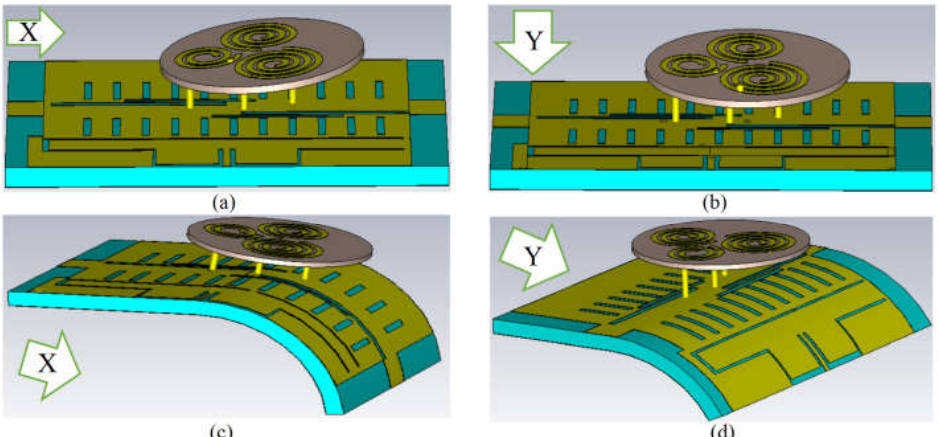
Figure 19. The crumpled antenna for both parts of the button and LWA towards the X ( a , c )- and Y ( b , d )-axis.